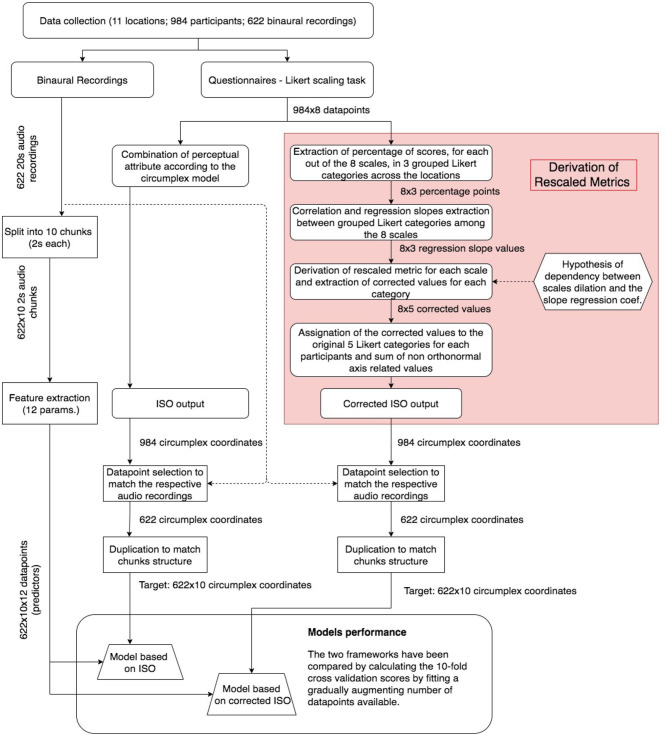
Flow chart of the methodology and data processing presented in this study.